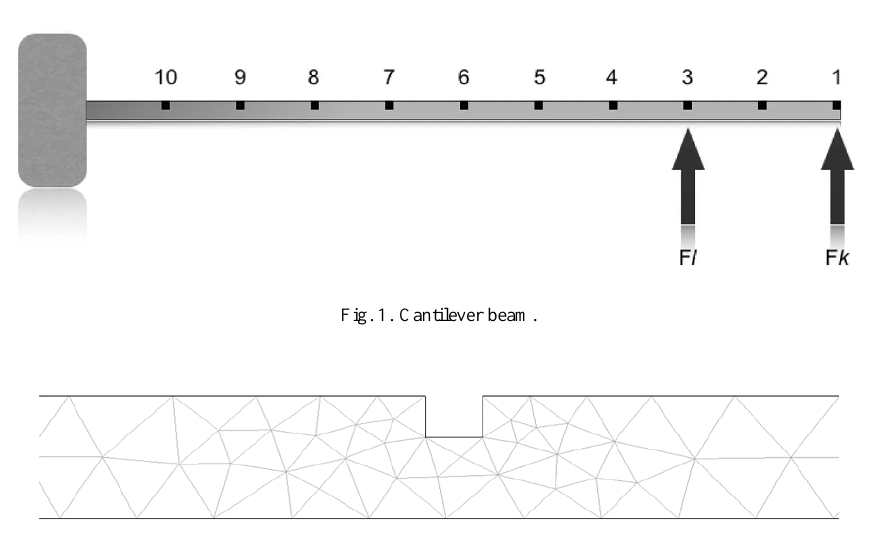
Fig. 2. Zoom on cut in finite element